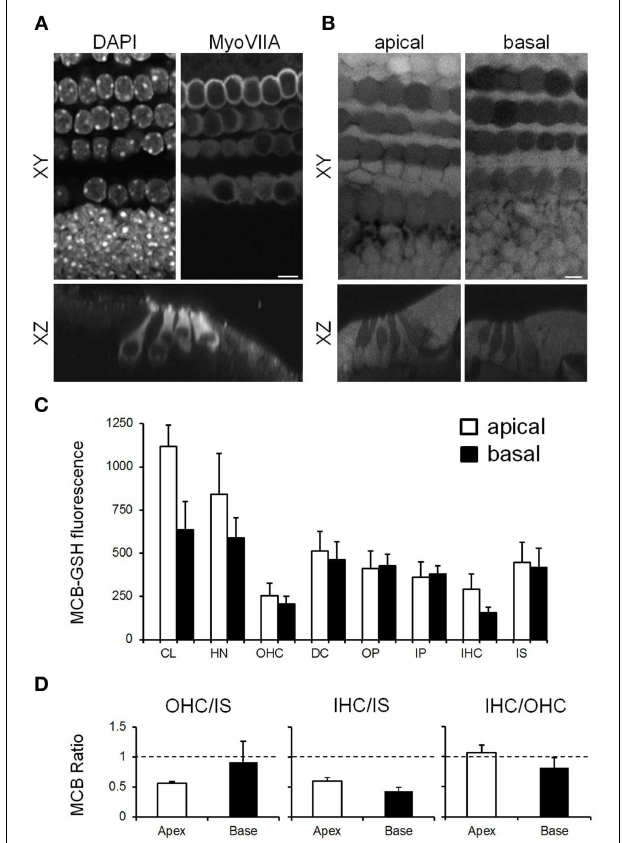
FIGURE 3 | Characterization of GSH content in cochlear explant cultures from P4–P6 mice (A) Confocal images from cultures fixed and immunolabeled with MyoVIIA and DAPI, showing MyoVIIA-positive inner (lower row) and outer hair cells (upper three rows) in XY and XZ profiles. (B) Multiphoton images from MCB loaded live cochlear cultures showing the relative GSH content in the apical and basal cochlear coil coils. Scale bar: 5 µ m. (C) Quantification of GSH content in the apical and basal cochlear turns. Absolute values measure in apical (white bars) vs. basal (black bars) turn cochlear cells: CL, HN, OHCs, DC, OP, IP, IHCs, and IS cells. (D) Average ratio values between cells within data sets for OHCs/IS, IHCs/IS, and IHC/OHC. Data presented are mean ± SEM; n = 3 –6 different cochlear explants from different animals for apical and basal cells.